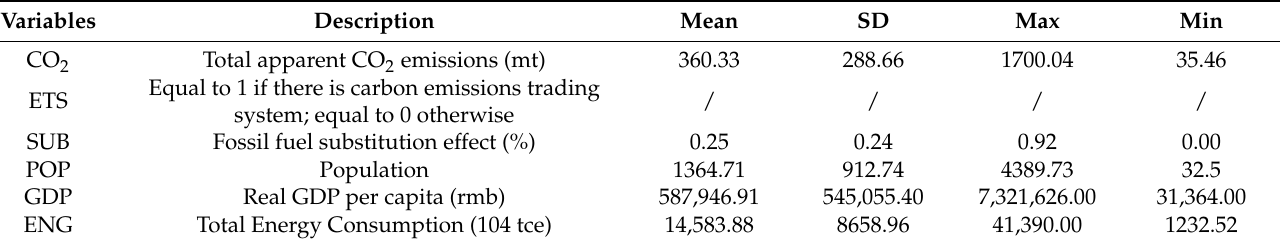
Table 2. Description and statistics summary of variables.